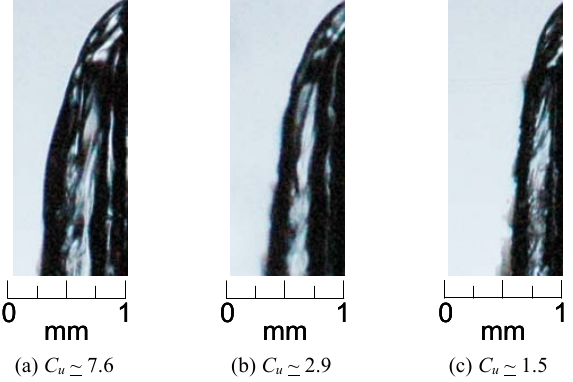
Fig. 5 Effect of C u on cavitation thickness ( W N ~ 4 mm, L = 16